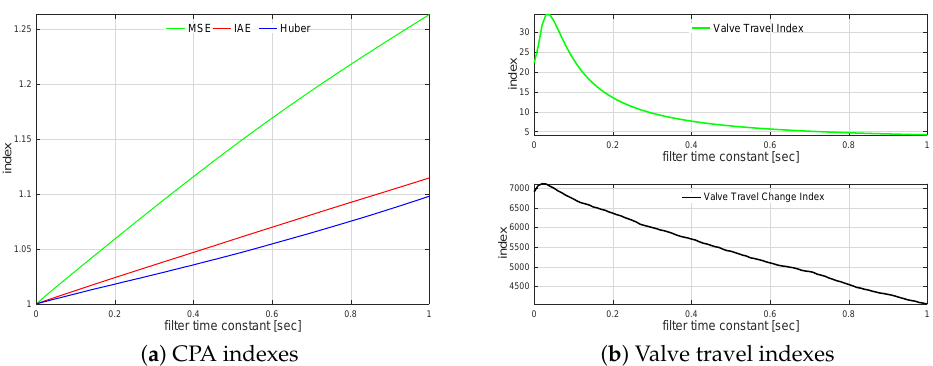
Figure 8. Control error filtering relationships for G 2 ( s )